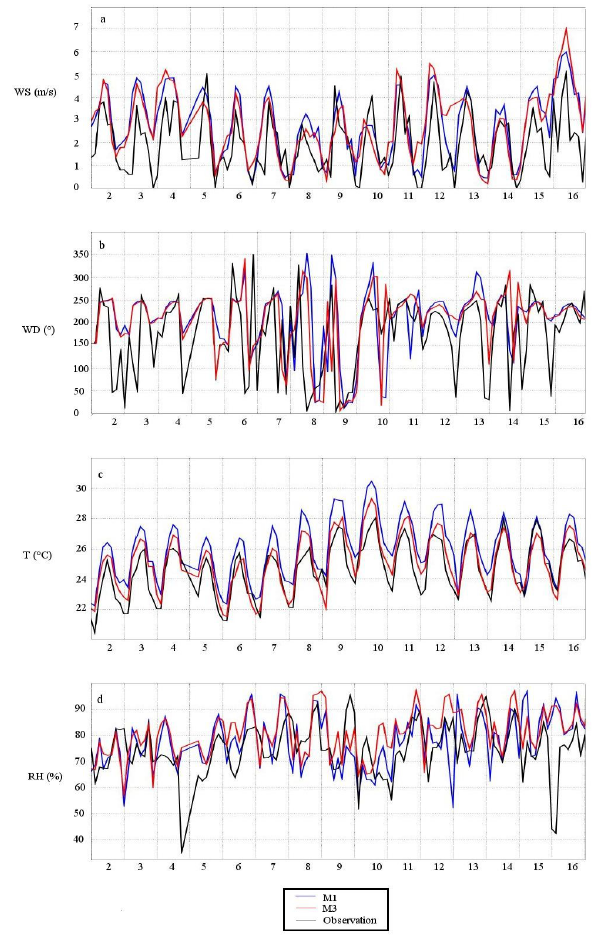
Figure 2. Temporal variation of meteorological variables (observations and model simulations 2 Fig. 2. Temporal variation of meteorological variables (observations M1 and M3) from July 2 till July 17, 2011; (a) : wind speed (m/s); (b) : wind direction (°); (c) 3 and model simulations M1 and M3) from 2 to 17 July 2011; (a) wind speed (ms − 1 ); (b) wind direction ( ◦ ); (c) air temperature ( ◦ C); : air temperature (°C); (d) : relative humidity (%)). 4 (d) relative humidity